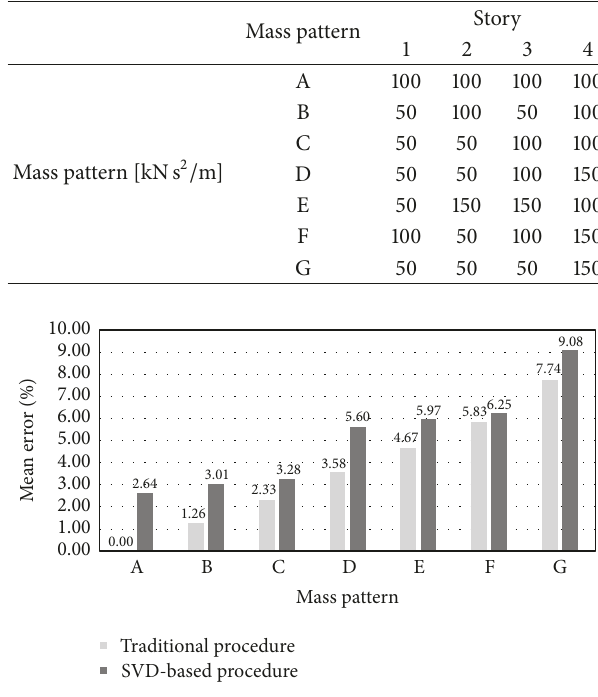
Figure 13: Comparison of average absolute errors on analytical flexibility matrix of the damaged condition, computed by traditional modal vectors-based procedure and SVD-based procedure with reference to the mass patterns of Table 11 and damage pattern D3 of Table